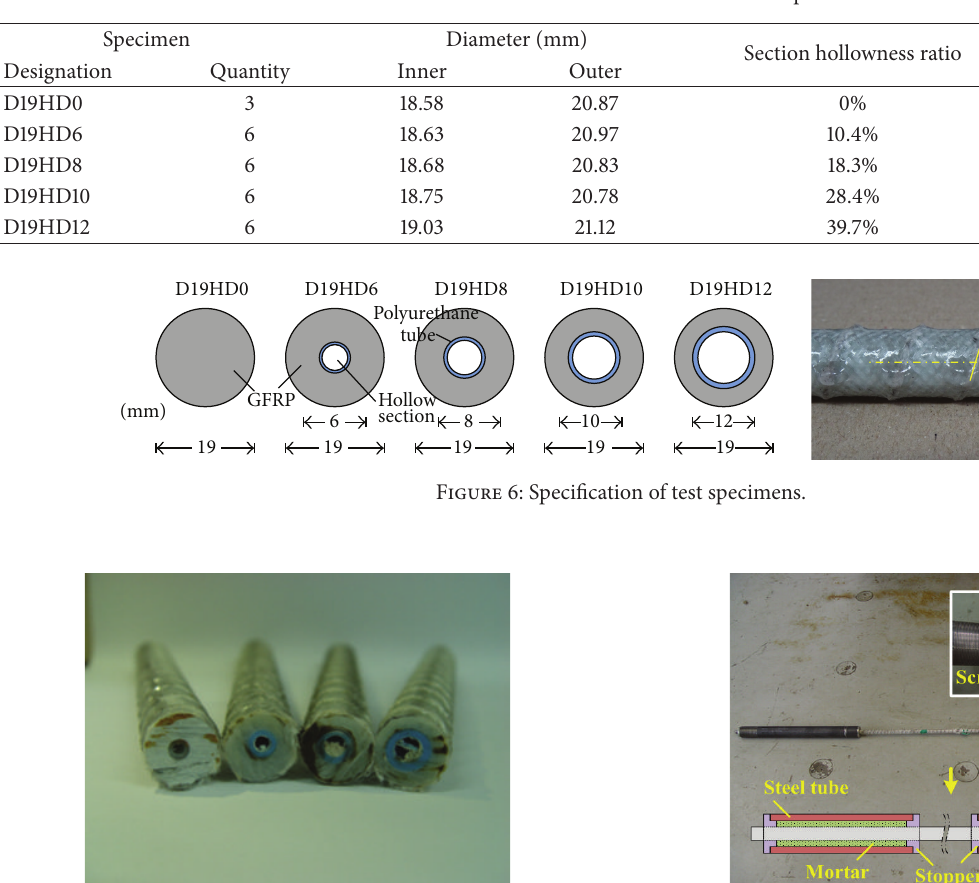
Table 2: Dimensions and characteristics of test specimens.